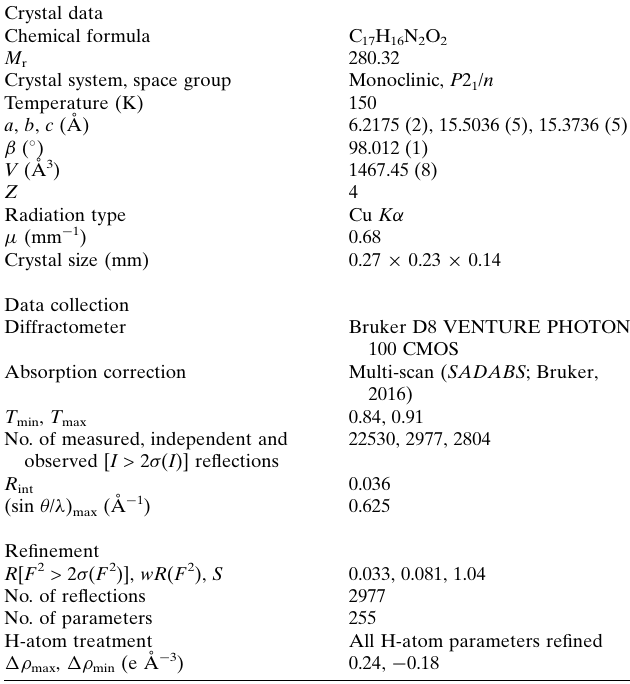
Table 2 Experimental details.